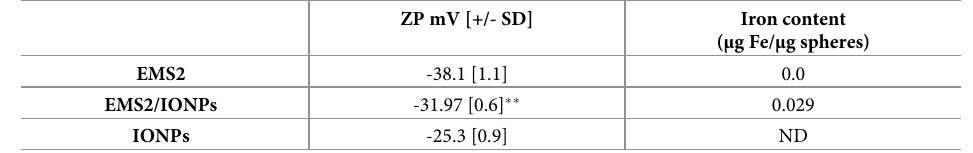
The spheres were produced by mixing 2 M potassium phosphate at a pH of 8 with silk (1 mg/mL) in the presence or absence of iron oxide nanoparticles (5 mg/mL). The results of the zeta potential show the mean value and SD of three experiments in triplicate. �� indicates statistical significance with p <